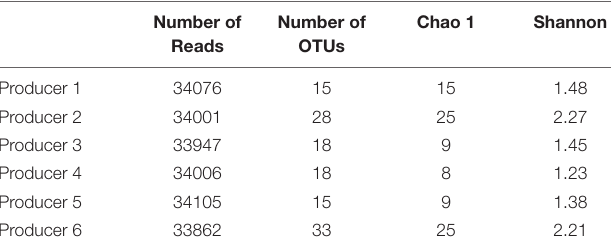
TABLE 3 | Comparison of estimates OTUs, richness and diversity indices of the 16S rRNA gene libraries as obtained from the pyrosequencing